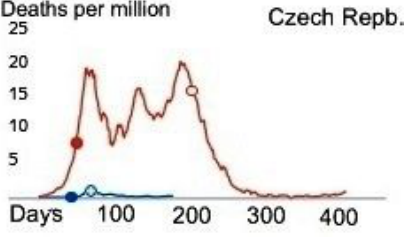
Figure 8. Dynamics of mortality per 1 million, February 2020 – Octo- ber 2021: pink line – Sweden (haplogroups I1+R1b+R1a), blue line – Germany (haplogroups R1b+ I1+R1a)